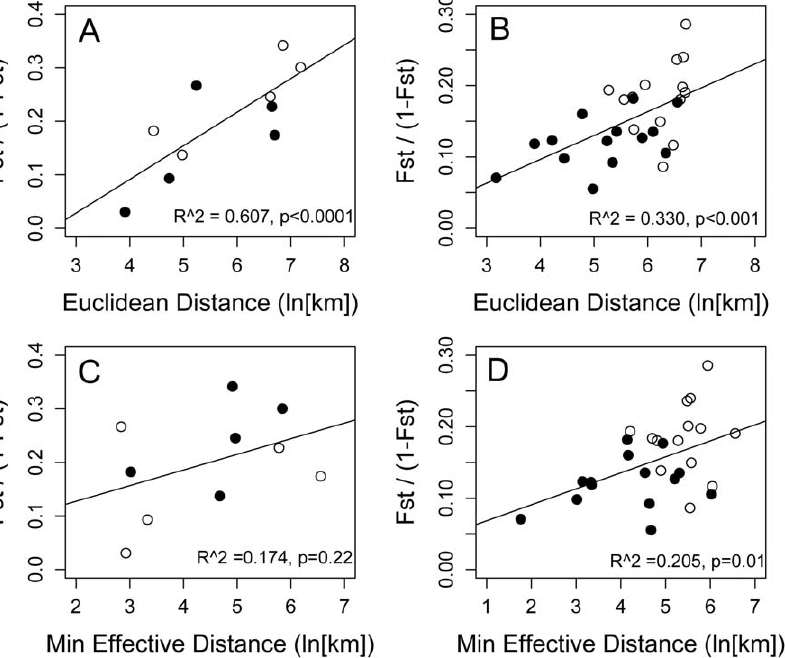
Figure 6. Isolation by distance. Isolation by distance plots using Euclidean (a,b) and effective (c,d) distance among genetic populations of Erophylla (a,c) and M. waterhousii (b,d). Filled circles represent pairwise comparisons included in the MIGRATE migration matrix and open circles represent pairwise comparisons excluded from this analysis. Regression lines are based on all points shown.